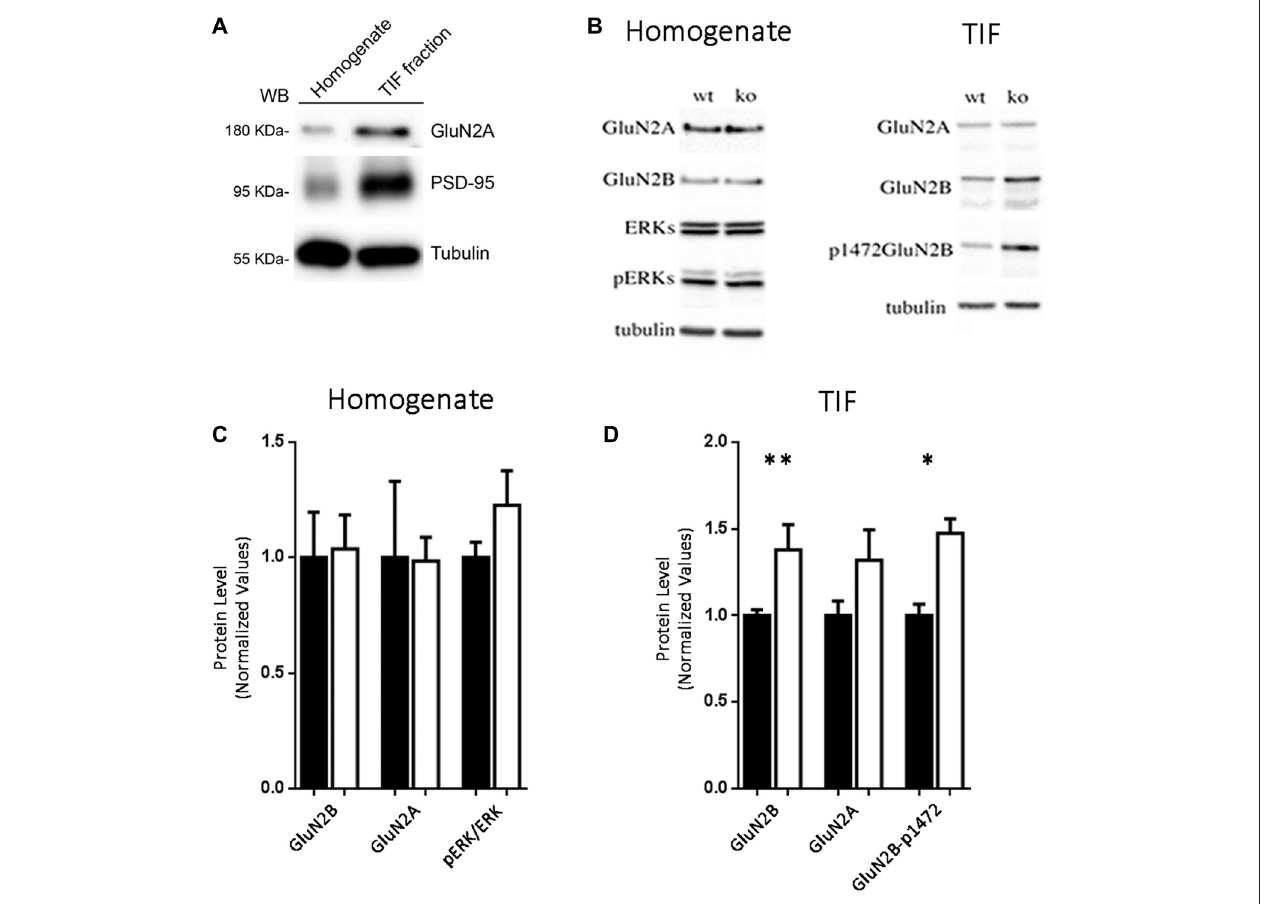
FIGURE 3 | Increased levels of GluN2B-containing and Y1472-GluN2B phosphorylated NMDARs in synaptic triton insoluble fraction (TIF) from Eps8 KO tissue. (A) Western blotting (WB) analysis confirmed that TIF preparation was actually enriched in postsynaptic proteins. (B–D) WB analysis and relative quantification in homogenate and TIF fractions for the indicated antibodies. All the WB were run twice (data are mean ± SEM, N = 4; Kruskal-Wallis test followed by Dunn’s multiple Comparison test ∗ P < 0.05, ∗∗ P <